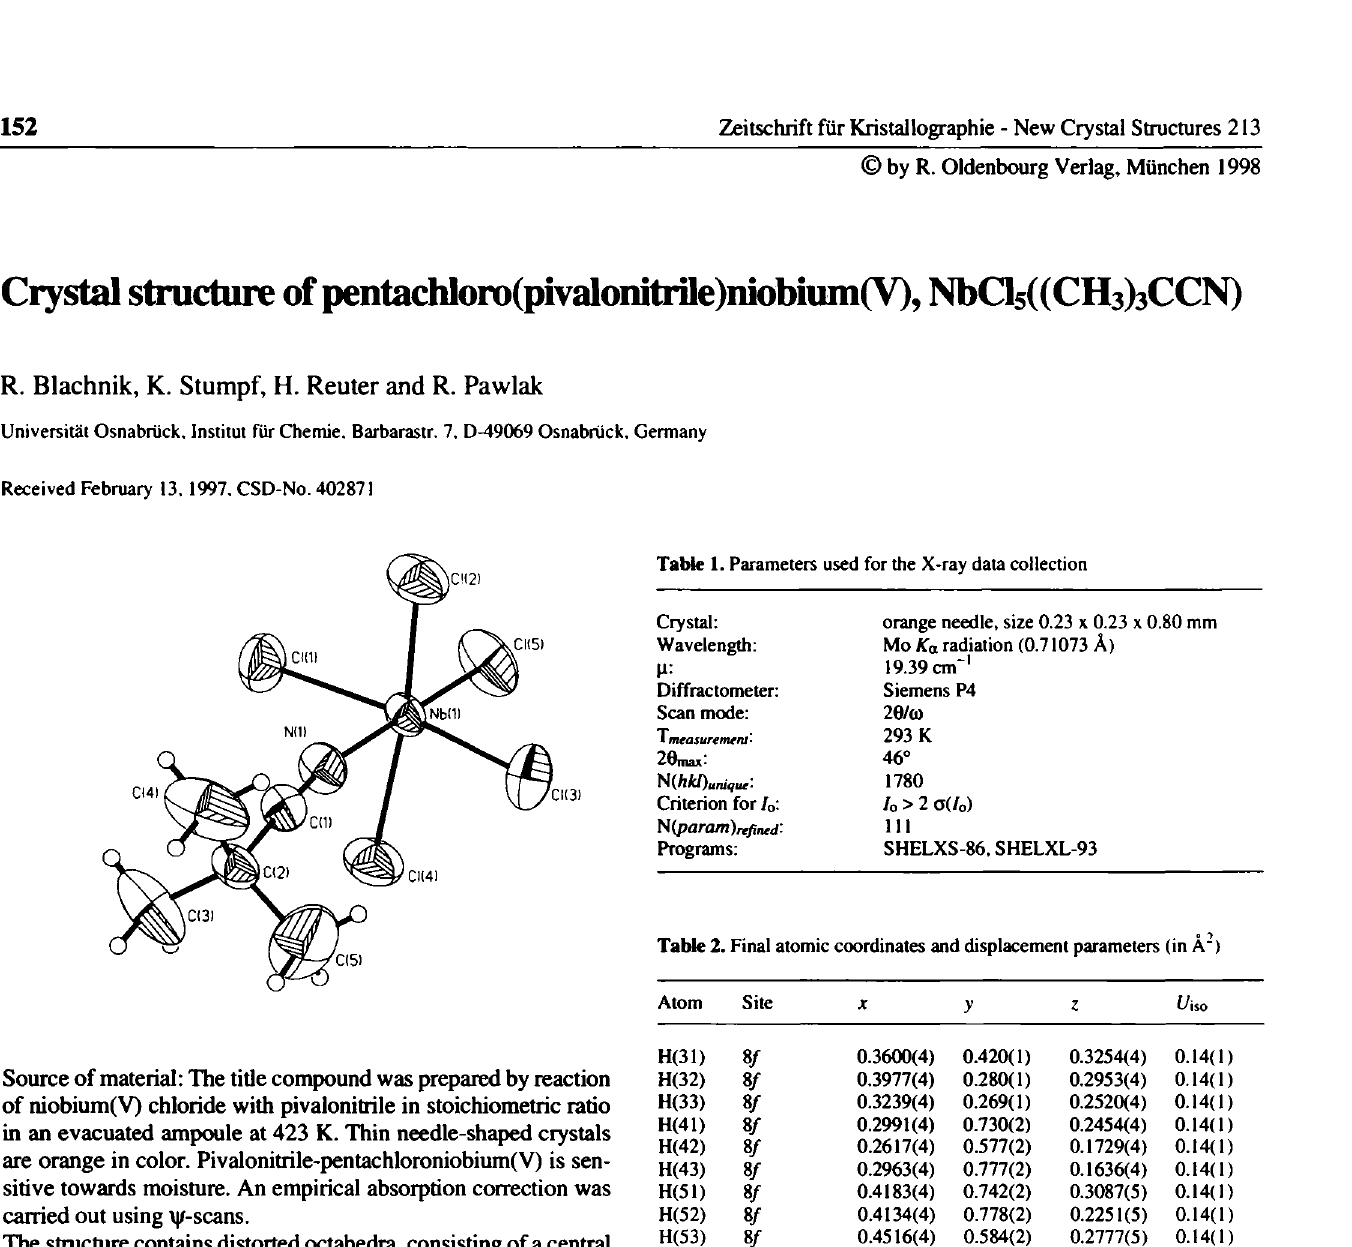
Table 3. Final atomic coordinates and displacement parameters (in Â^)